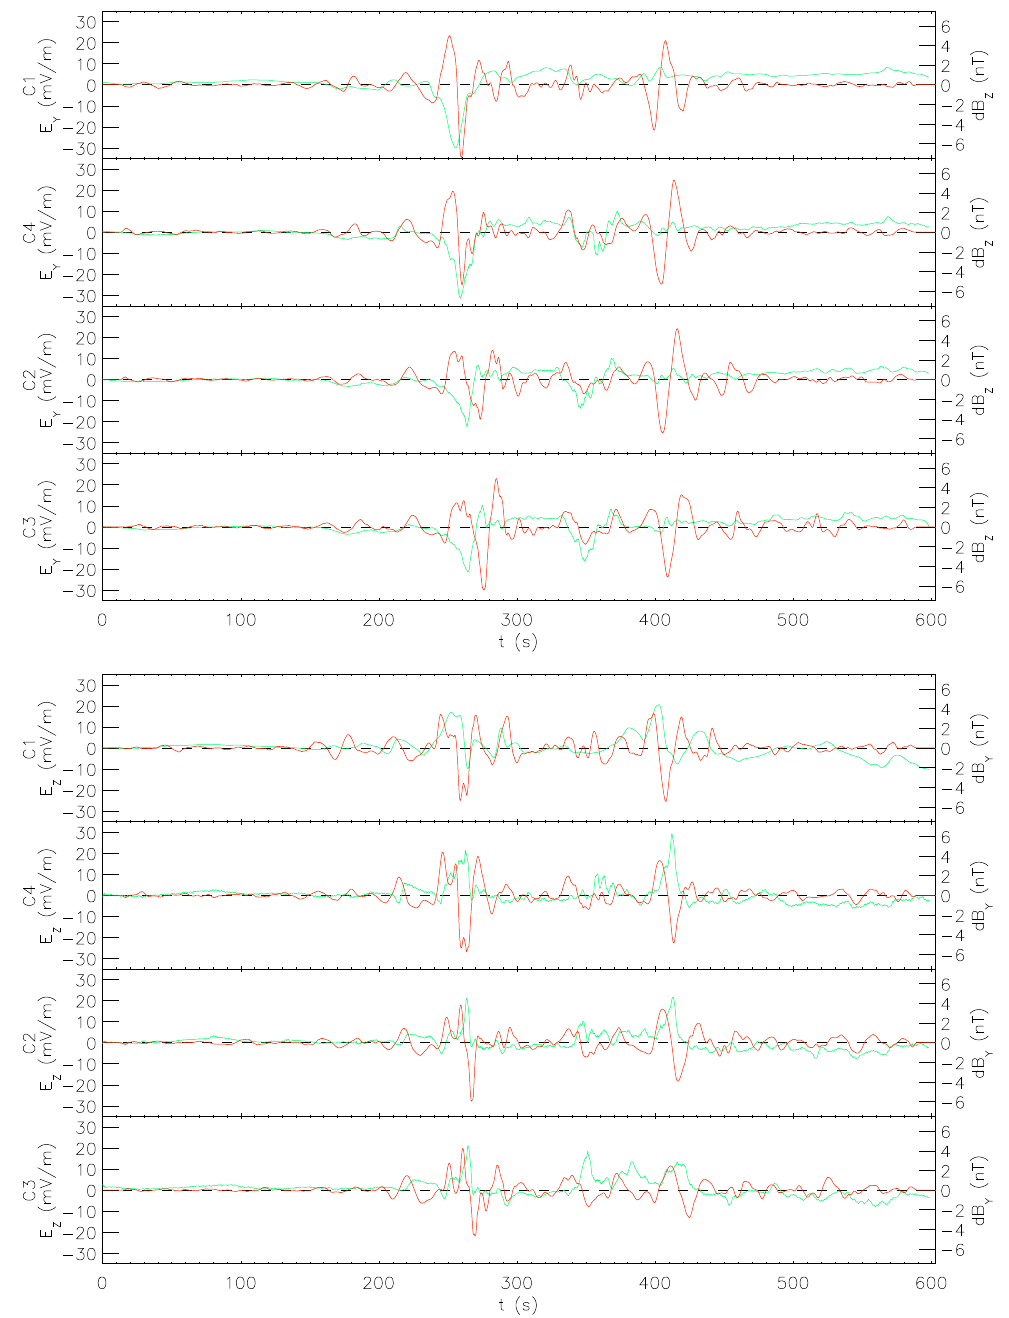
Fig. 4. Comparison of mutually perpendicular components of the electric field E (green) and the residual magnetic field d B (red) for the four Cluster satellites. y and z are approximately to the geomagnetic west and north, respectively, and the order of the panels is the order in which the Cluster satellites encounter the quasi-static structures of intervals (1) and